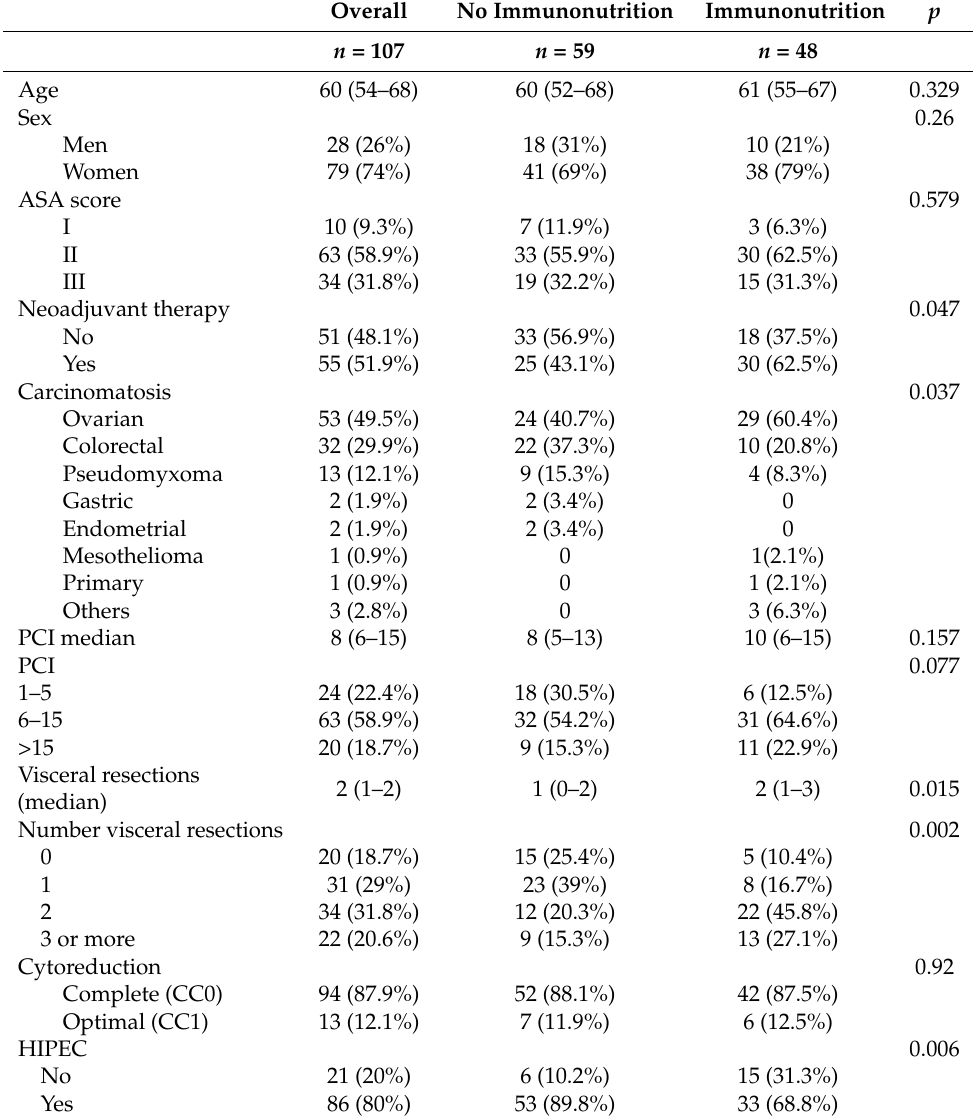
Table 1. Baseline and surgical